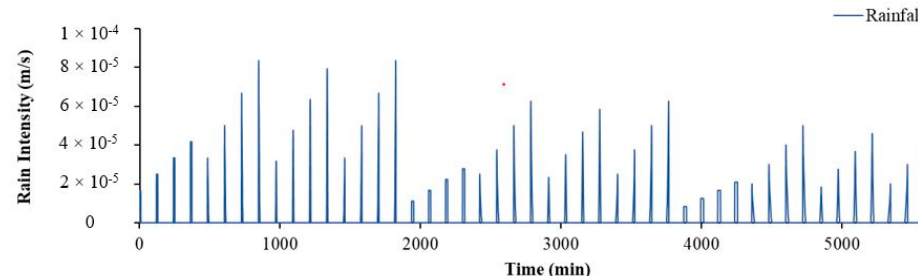
Figure 5. Pump flow rates as the output of the seepage analysis in a typical generated rainfall event (duration = 15 min, rainfall depth = 15 mm, and pattern “d”).